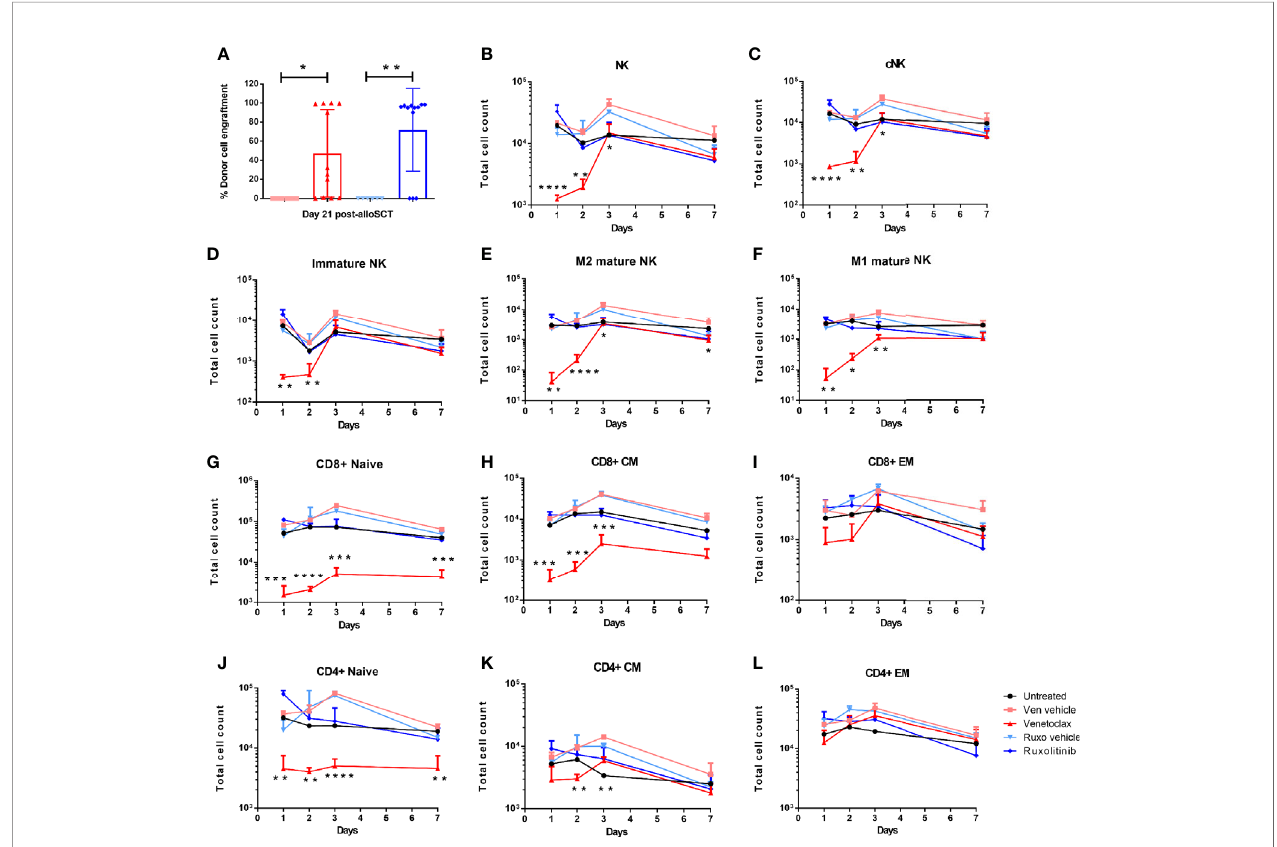
FIGURE 3 | Donor cell engraftment is dependent on recipient pre-alloSCT irradiation dose and treatment with BCL2 or JAK1/2 inhibitors. WT mice were treated with venetoclax or ruxolitinib, or their respective vehicle for two days. The following day mice were treated with RIC and alloSCT. (A) Donor cell engraftment (H2kd+ cells) was measured in the blood at day 21 post-alloSCT. WT mice were treated with venetoclax or ruxolitinib, or their respective vehicle for two days. Mice (n=3-4/ group) were killed on days 1, 2, 3, and 7, and BM was harvested and analysed by fl ow cytometry for the absolute number of (B – F) NK cells (NK1.1+CD3-), cNK (NKp46+CD49b+), M1 mature (CD11b+CD27+), M2 mature (CD11b+CD27-) and immature (CD11b-CD27+) NK cells; (G – L) naive (N; CD44-CD62L+); central memory (CM; CD44+CD62L+); effector memory (EM; CD44+CD62L-) CD4+ and CD8+ T cells. Data is representative of 3 independent experiments. Statistical analysis was performed using unpaired T test. *p < 0.05, **p < 0.01, ***p < 0.001, ****p <